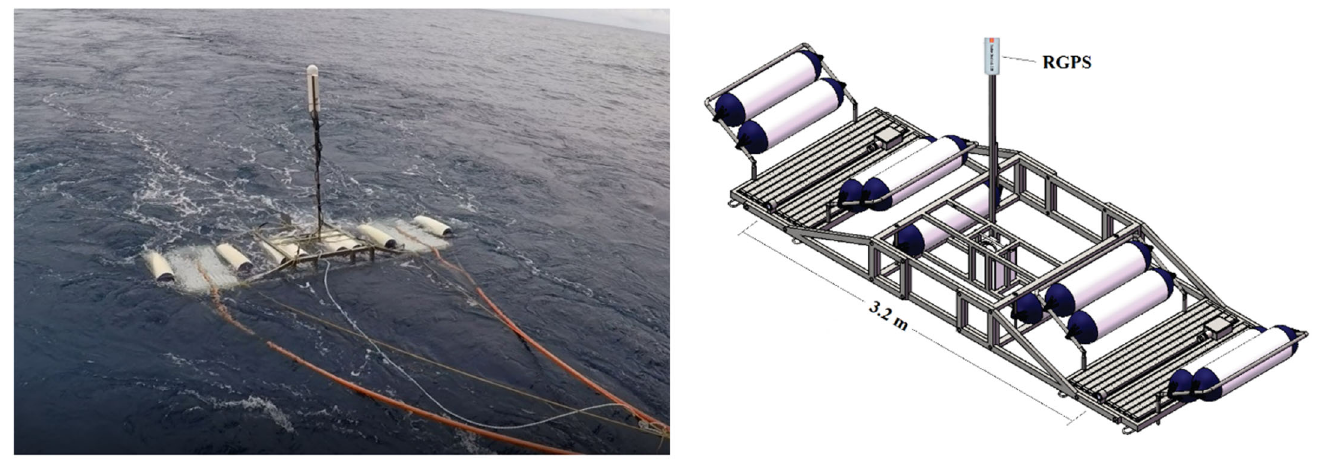
Figure 3. Plasma source array.